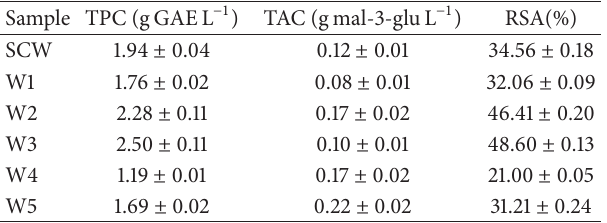
Table 1: Total phenolics contents, total anthocyanin contents, and radical scavenging activity in six wine samples a